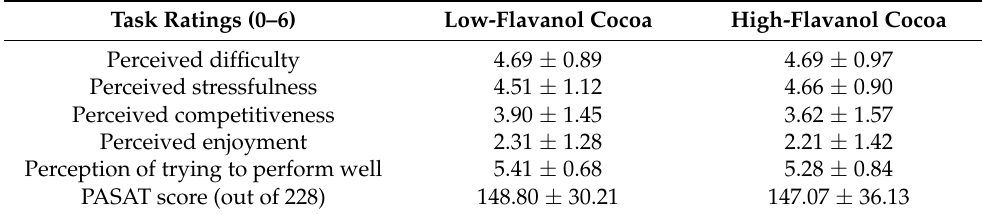
Table 3. Task Ratings and Performance (Mean ± SD, n =